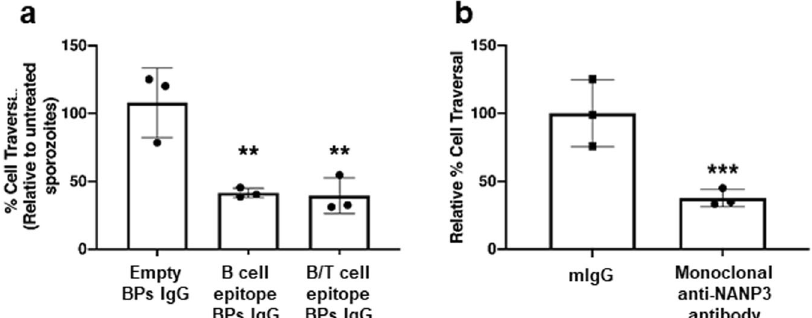
Fig. 6 Antibodies from vaccinated sheep bind P. falciparum sporozoites and inhibit traversal through hepatocytes. a HC-04 cell traversal by sporozoites in the presence of antibodies from sheep vaccinated with empty BP, B-cell epitope-coated BPs and B/T-cell epitope-coated BPs, respectively. b HC-04 cell traversal by sporozoites in the presence naïve mouse IgG (mIgG) or monoclonal anti-NANP3 (clone 2A10) served as negative and positive control, respectively. For gating strategy see Supplementary Material Fig. 1. Data shown are pooled from three independent experiments relative to the no sporozoites control. p < 0.01 using Wilcoxon test. ** indicates statistical signi fi cance from empty BPs. *** indicates statistical signi fi cance from the mouse IgG negative control. All antibodies were used at 10 μ g/ml. All data are mean and error bars represent + / –